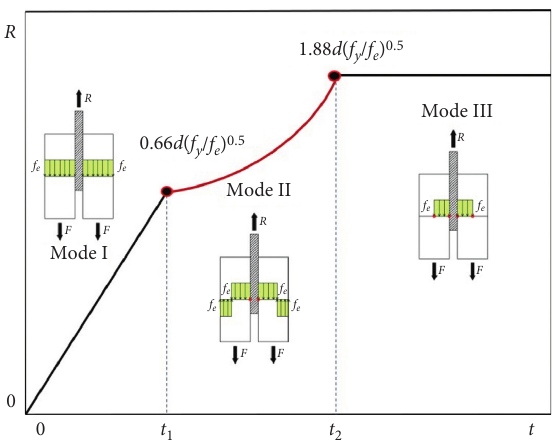
Figure 7: The boundary conditions of the load-carrying capacity of the connections.